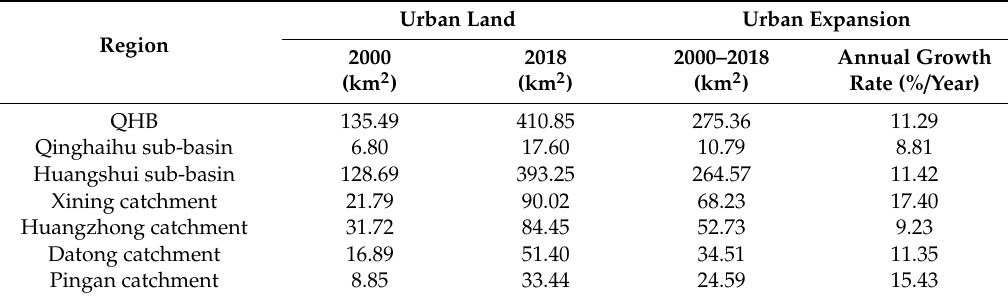
Figure 4. Urban expansion from 2000 to 2018. Table 4. Urban expansion from 2000 to